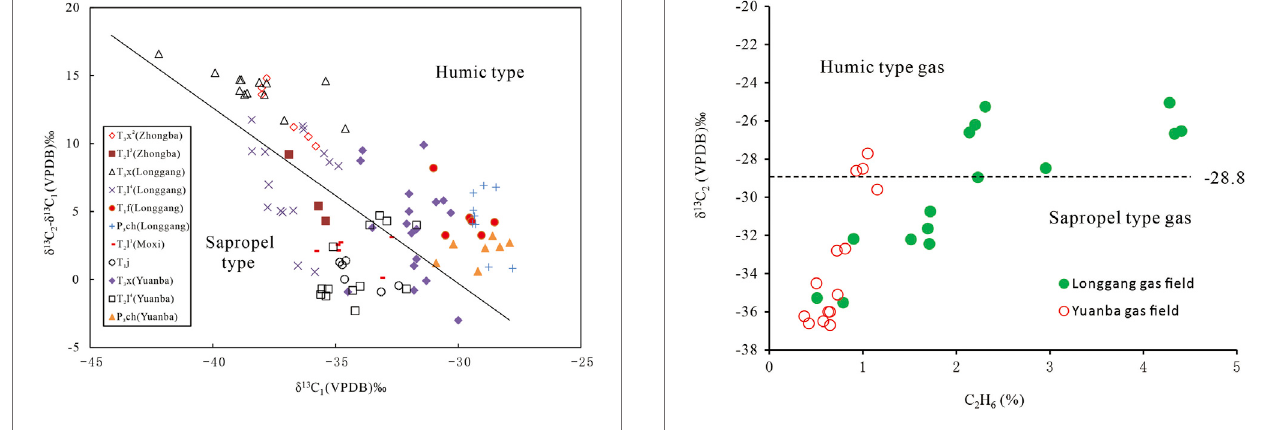
FIGURE 4 | Genetic types of natural gas in the T 2 l 4 reservoir of the Sichuan